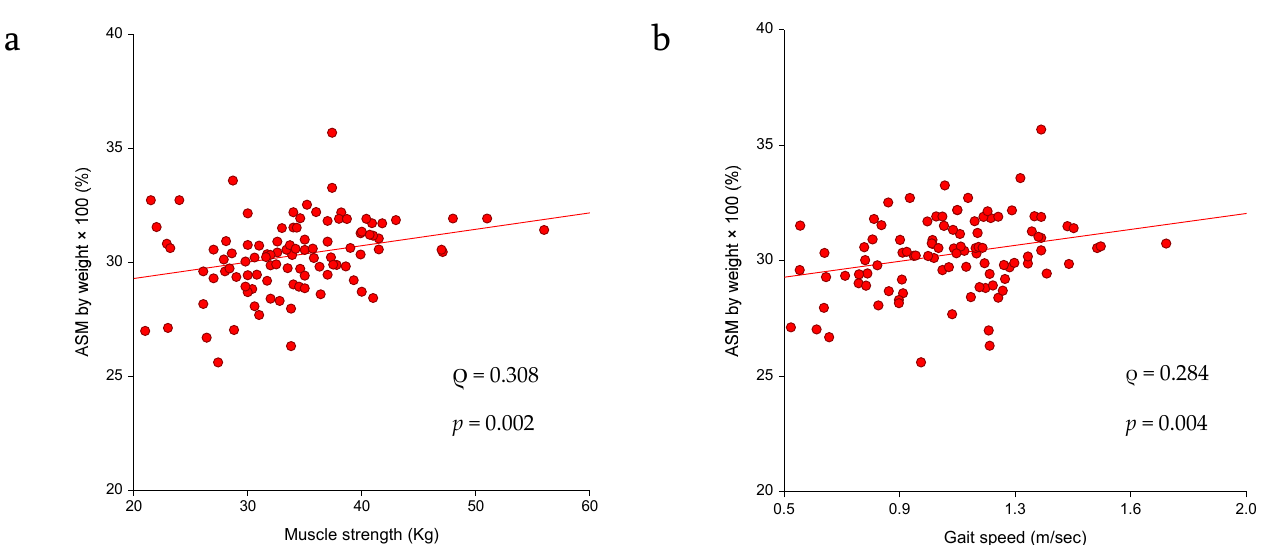
Figure 1. ( a ) Association between low SMM and handgrip strength (kg) and also ( b ) gait speed (m/s) in the study sample (n = 102).